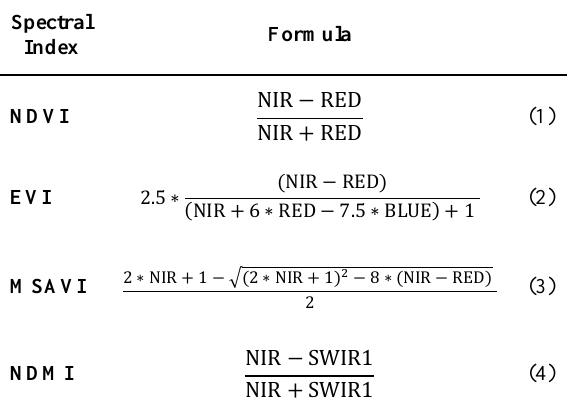
Table 1 : Spectral Indices for time series analysis A recent study on the mangrove forest degradation and regeneration in the eastern coast of the Red Sea (Aljahdali et al., 2021) made use of a time series analysis of the moisture and vegetation indices to monitor mangrove health. The MSAVI and NDMI performed best in identifying vegetation trend patterns and forest disturbance and recovery in terms of water stress,